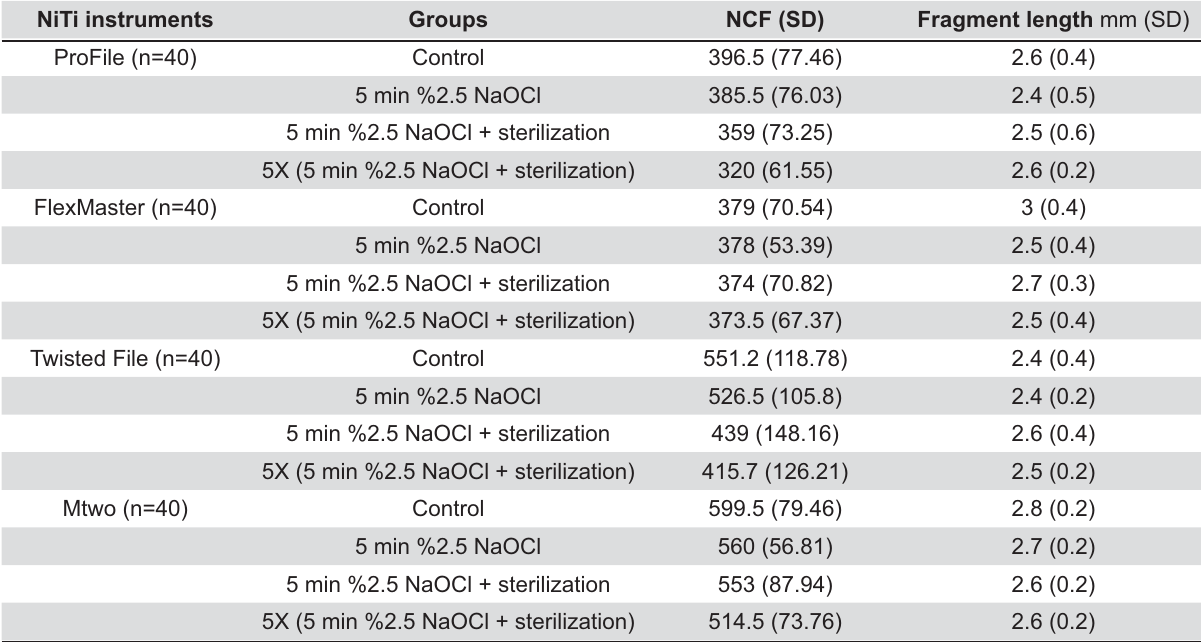
Table 2- Mean (SD) of the number of cycles to failure (NCF) and fragment lengths in mm (SD) of tested NiTi instruments according to the